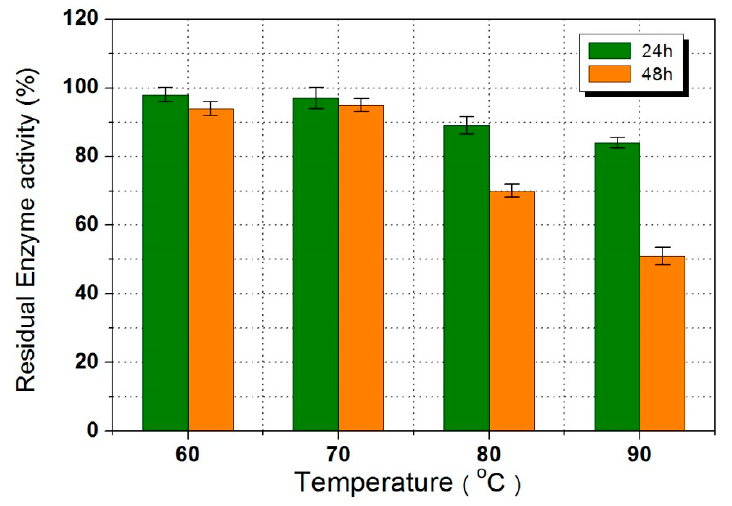
Figure 3. Residual enzymatic activity after 24 and 48 h of reaction at different temperatures.